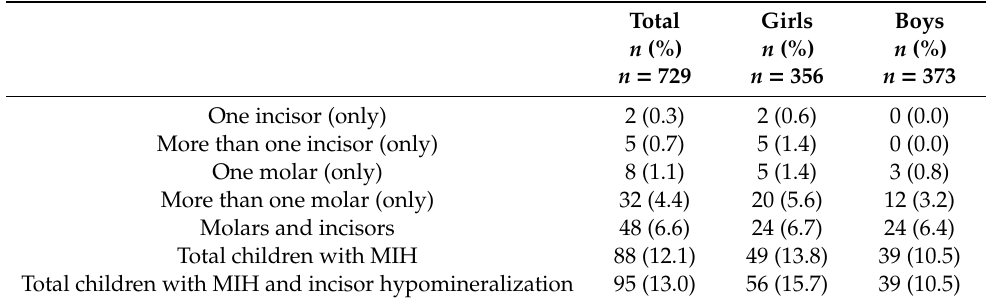
Table 4. Distribution and prevalence of hypomineralization lesions in permanent teeth.